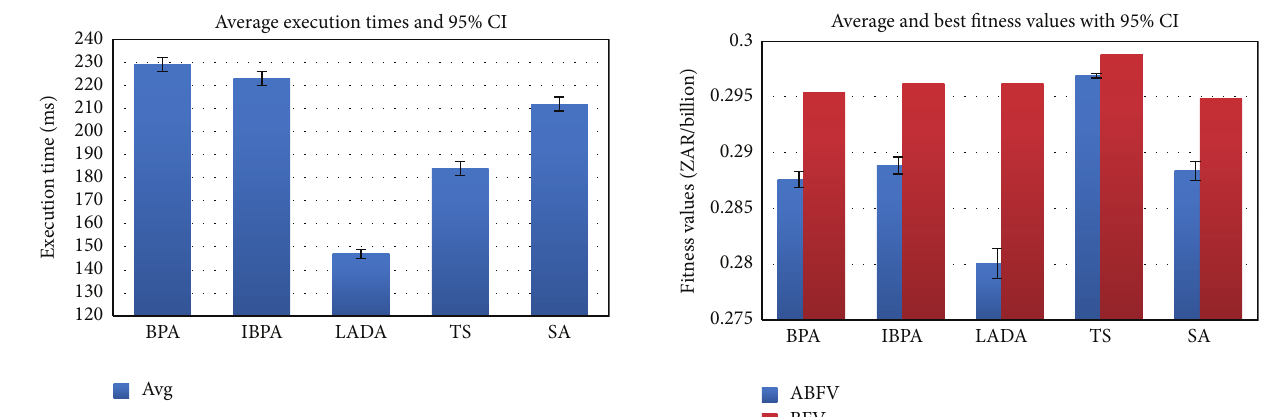
Figure 2: The average execution times, in milliseconds (ms), and the 95% CI values of each heuristic algorithm. Table 5: Statistics for the Best Fitness Values (BFVs), Average Best Fitness Values (ABFVs), and 95% Confidence Interval (95% CI) values.